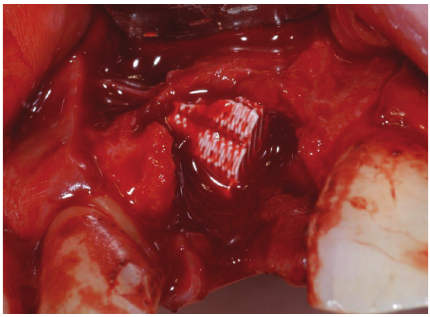
Figure 5: The socket was filled with a synthetic, micromacroporous biphasic calcium-phosphate (BCP)